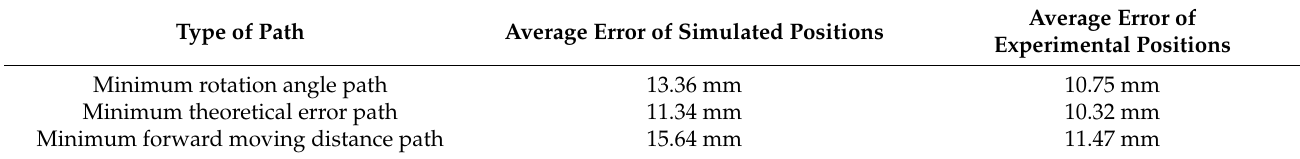
Table 5. Average error of simulation and experiment